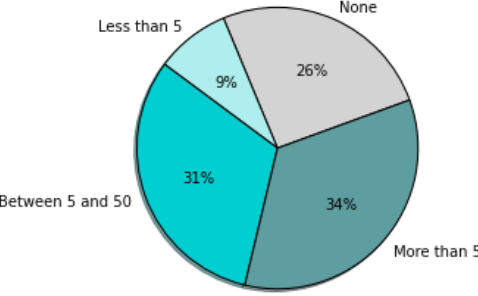
Figure 4. Number of machines in the analyzed companies.